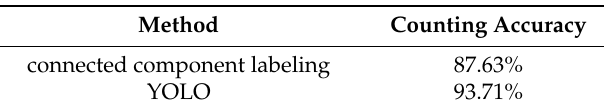
Table 1. Counting accuracy comparison.